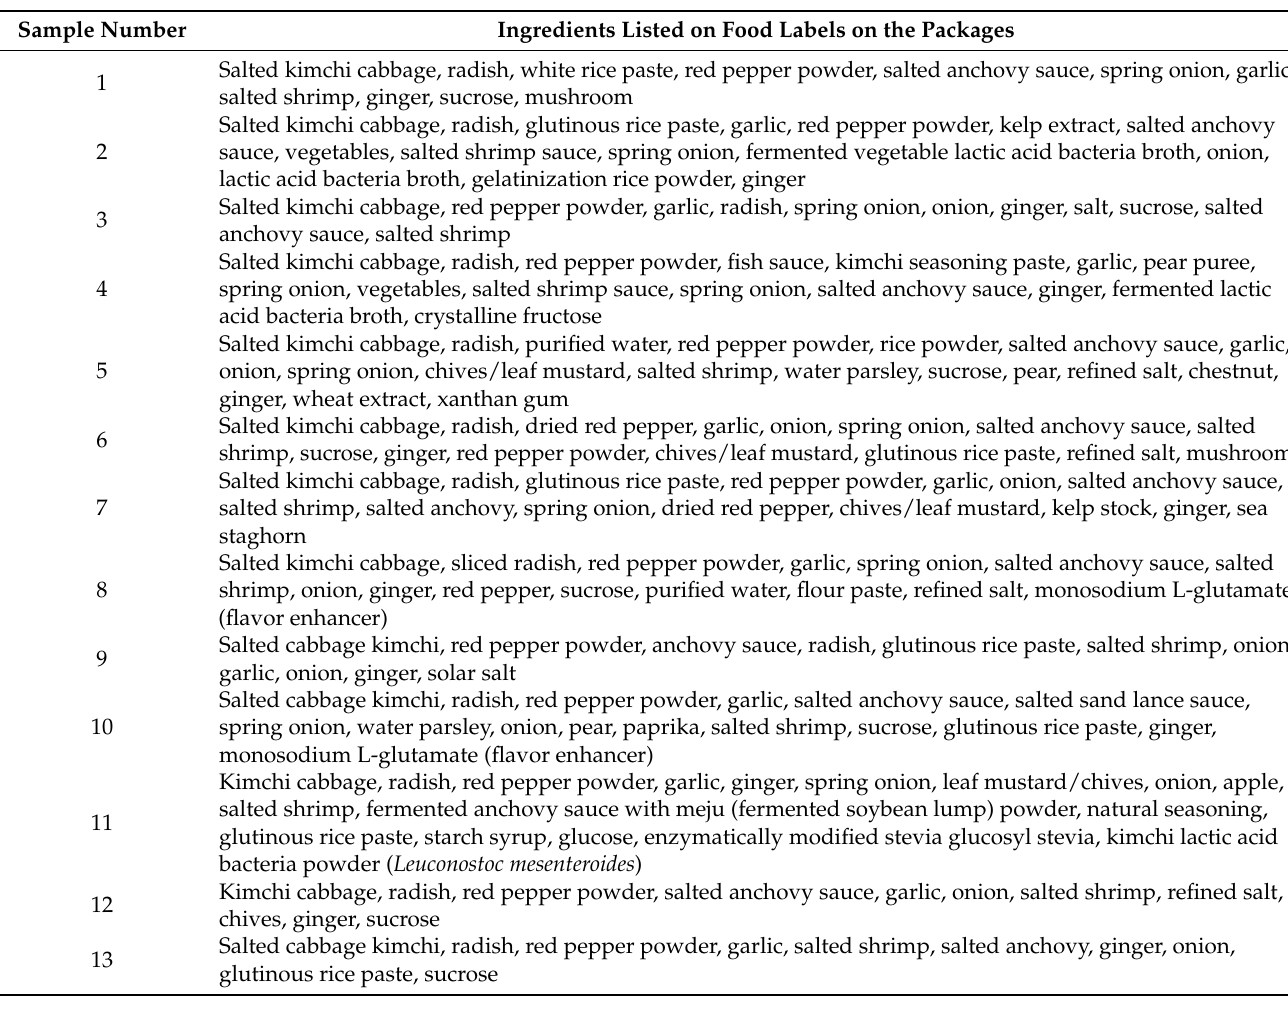
Table 1. Ingredients in 13 commercial kimchi samples in this study. Ingredients Listed on Food Labels on the